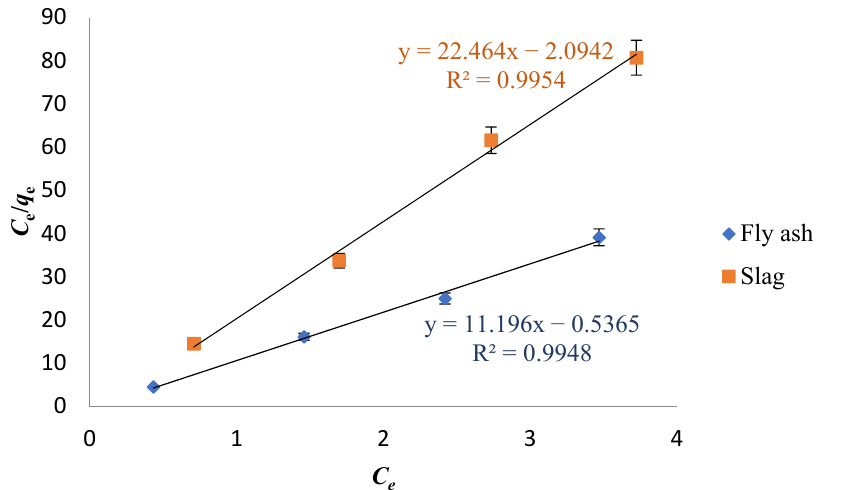
Figure 8. The Cs adsorption of the Langmuir isotherm on the fly ash-based geomaterials and slag-based geomaterials.